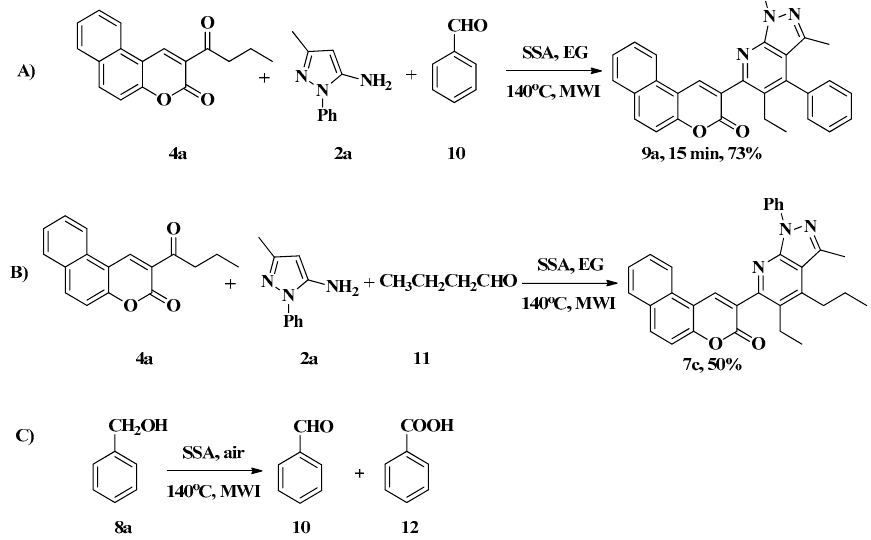
Table 2. Synthesis of coumarin-fused pyrazolo[3,4- b ]pyridine derivatives 9